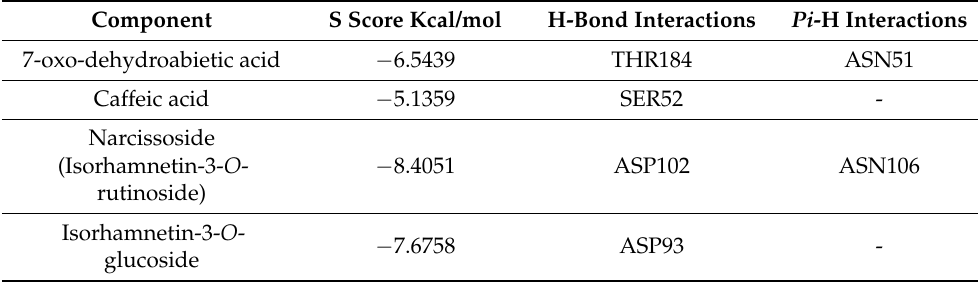
Table 3. Docking details of the selected components of ARBE on